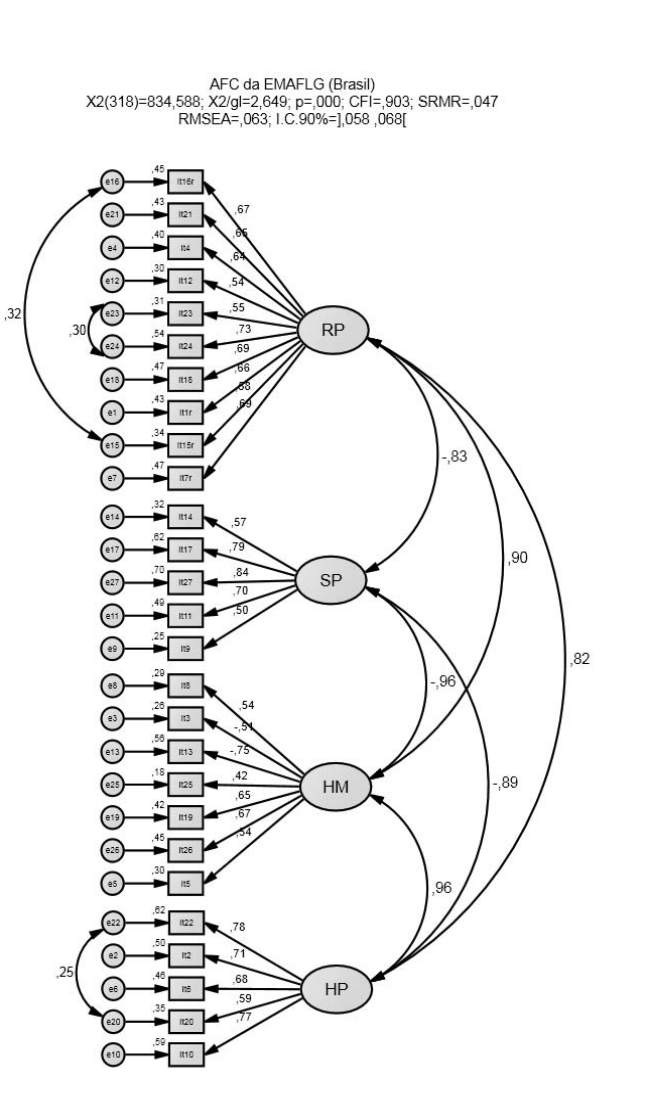
Figura 2 . Análise fatorial con fi rmatória da EMAFLG na amostra brasileira ( N =